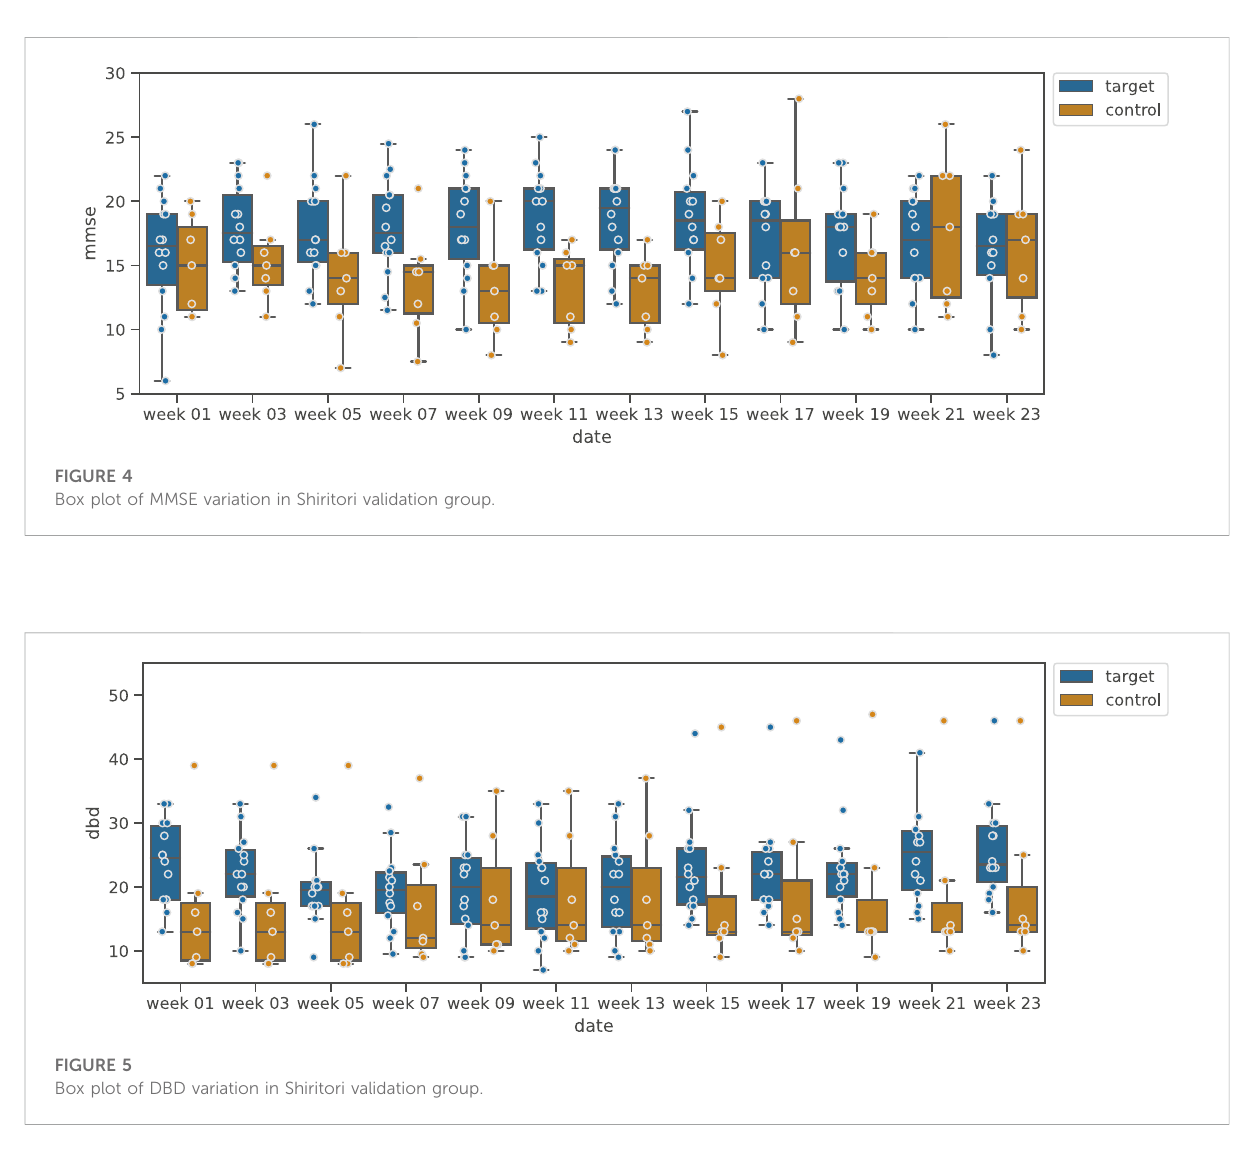
FIGURE 5 Box plot of DBD variation in Shiritori validation